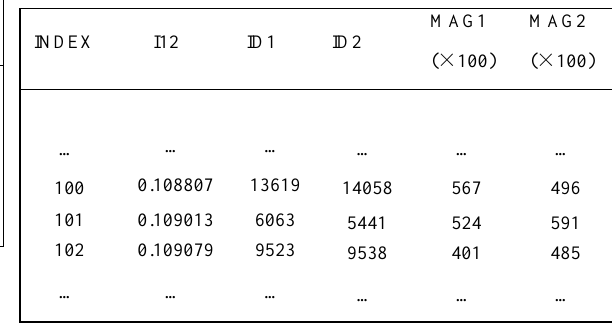
Table 5 The star Database with magnitude information. The MAG1and MAG2 respectively denotes the magnitudes of two stars in star catalog. As an important matching parameter, the star magnitude can be used to eliminate the false candidate matching result further. The regulation is described by formula (3). The mag1and mag2 denote two measured magnitudes of angular distance, and T E and T Mag denote angular distance and magnitude